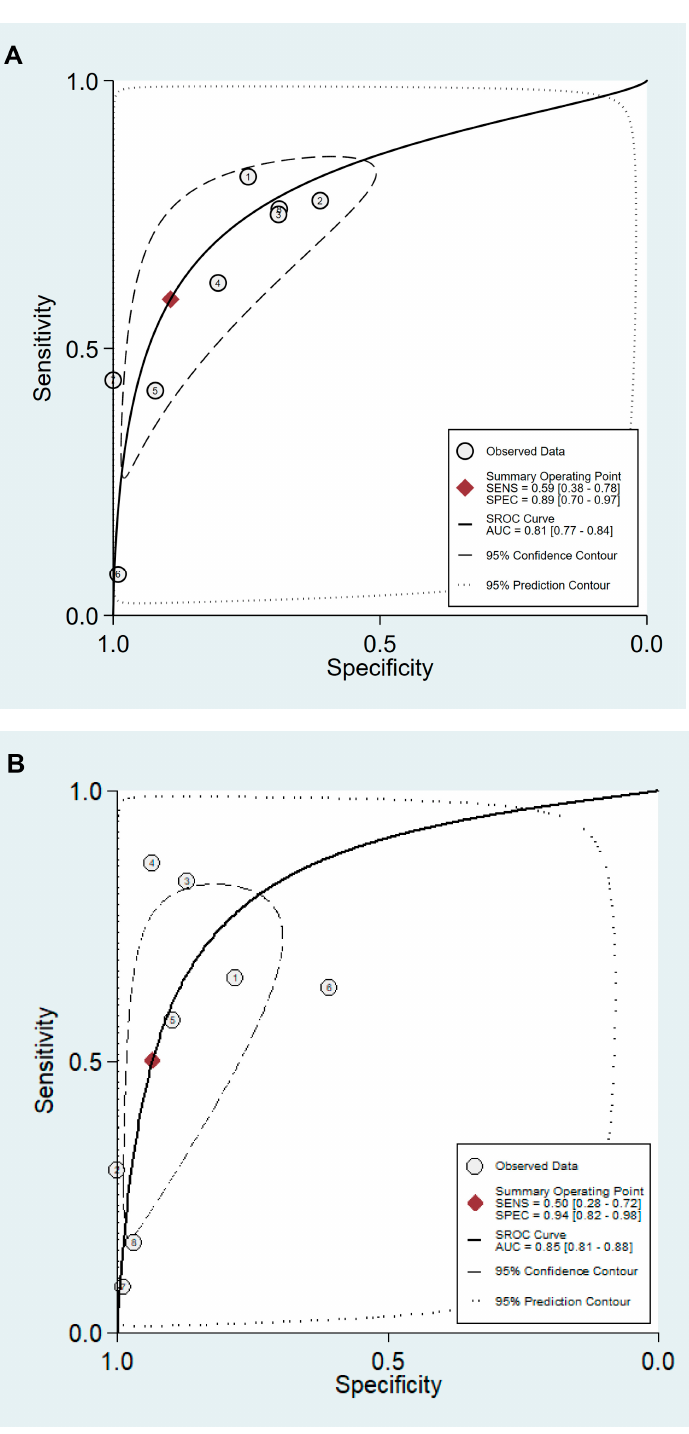
Figure 5. SROC curve with 95% confidence region and prediction region for the diagnosis of CAG. ( A ) cut-off value with PG I ≤ 70 ng/mL and PG I/PG II ratio ≤ 3, ( B ) cut-off value with PG I/PG II ratio ≤ 3. SROC, summary receiver operating characteristic; CAG, chronic atrophic gastritis; PG, pepsinogen; SENS, sensitivity; SPEC, specificity; AUC, area under the curve.